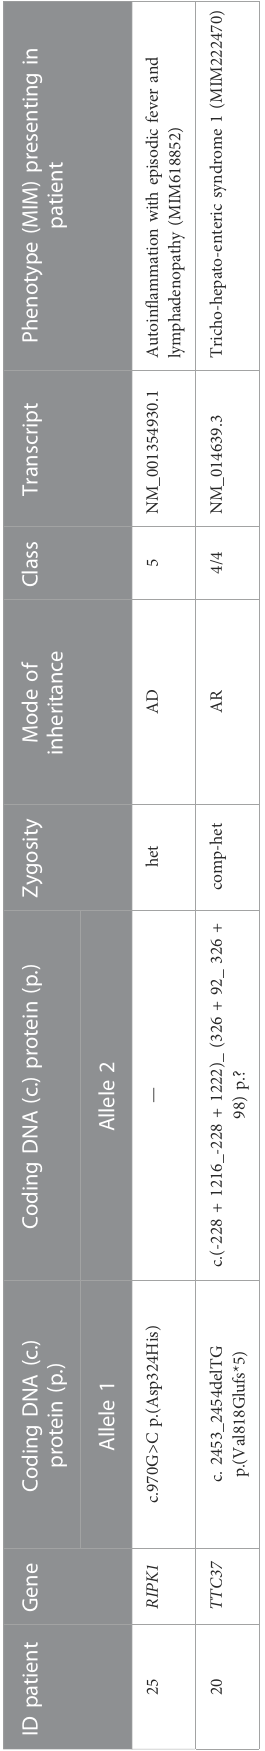
Supplementary Table S3. On average, the latency between disease manifestation and genetic workup was 3 years (0.1 – 14.5